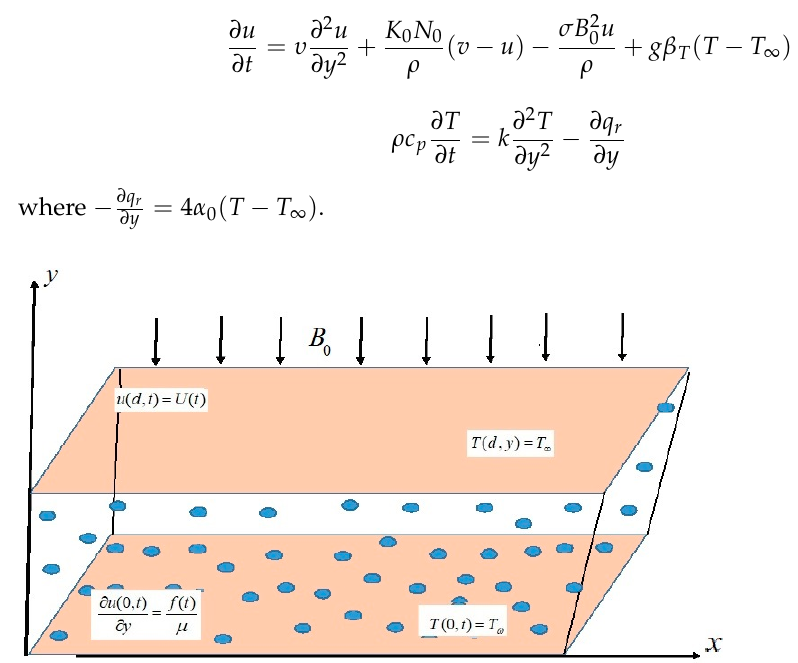
Figure 1. Geometry of the problem.